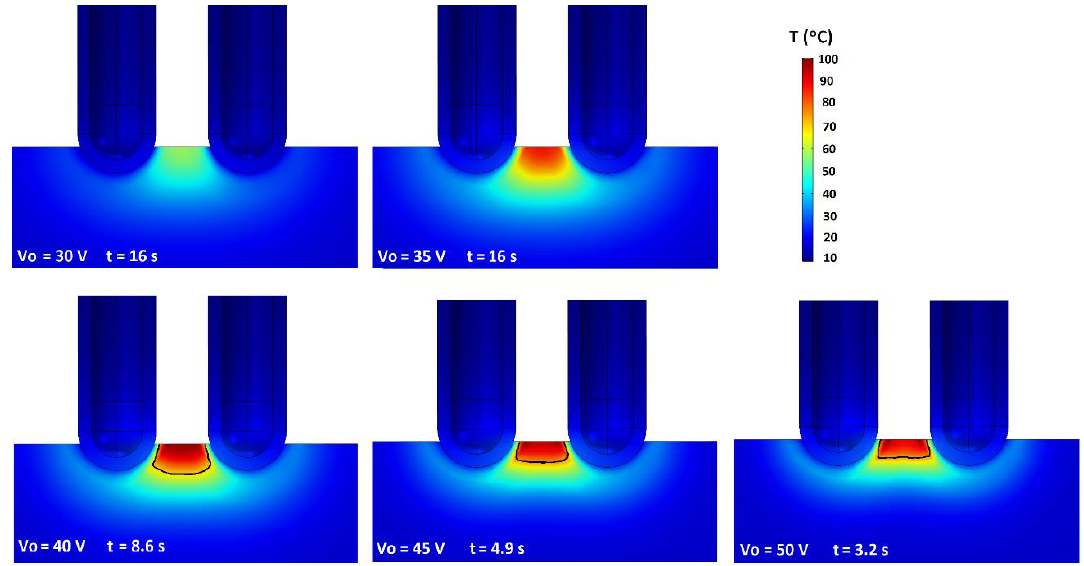
Figure 5. Temperature distribution (°C) and isosurface Ω = 1 (black line) for the BM in the symmetry plane of the geometry representing cases of V 0 = 30 (t = 16 s), 35 (t = 16 s), 40 (t = 8.6 s), 45 (t = 4.9 s), and 50 V (t = 3.2 s), as selected in Table 2. The times in each graph are the times that satisfied the stop criterion.